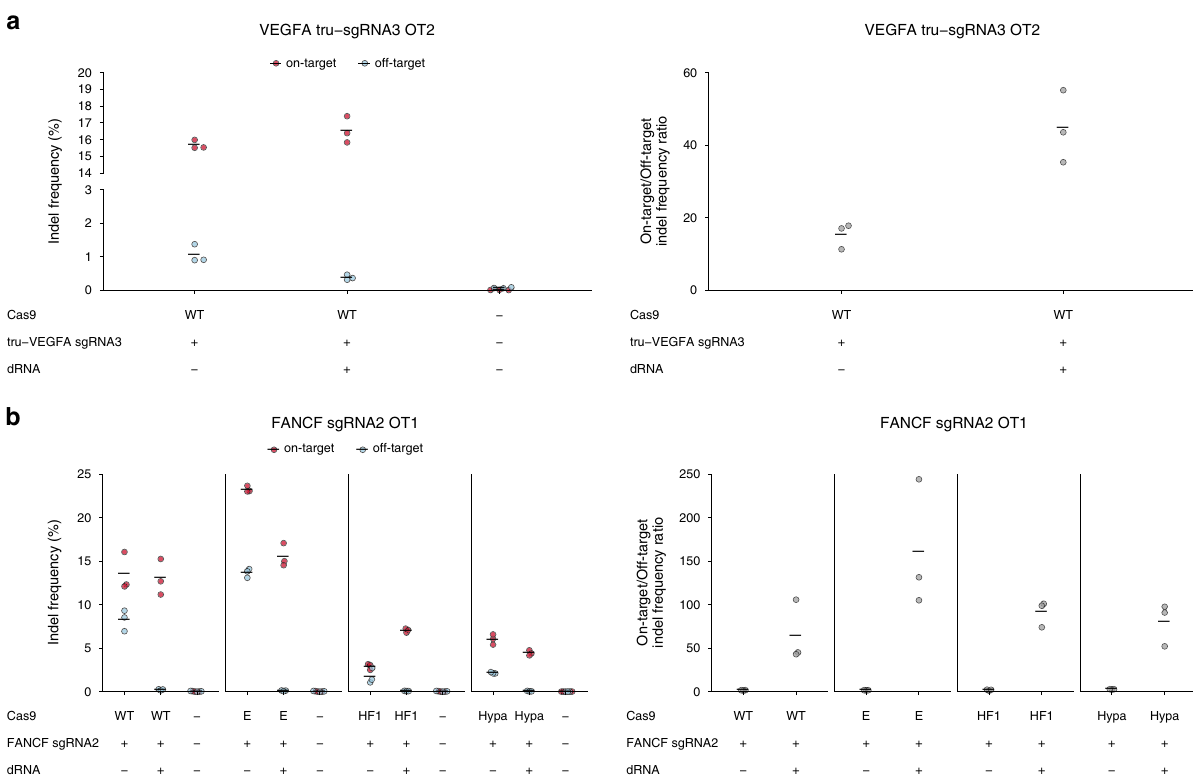
percentage of all edited sites exhibiting scarless HDR from 9.53% (s.e.m. = 0.40, n = 3) to 19.72% (s.e.m. = 0.52, n = 3; Fig. 6c).